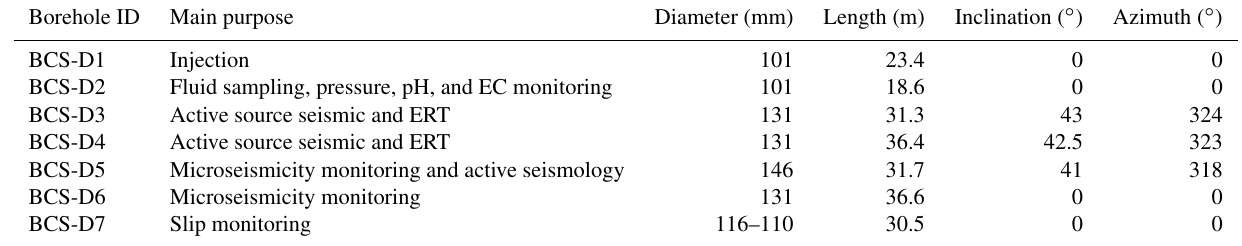
Table 1. Parameters defining the CS-D boreholes: inclination equals deviation from the vertical (vertical 0 ◦ ); borehole depth is approximately 0.5m. The order of the boreholes in the table represents the drilling sequence. The borehole BCS-D7 has an initial diameter of 116mm from 0 to 13.60 and a diameter of 101mm from 13.60 to 30.5 due to overcoring to retrieve a stuck drill bit. ERT: electrical resistivity